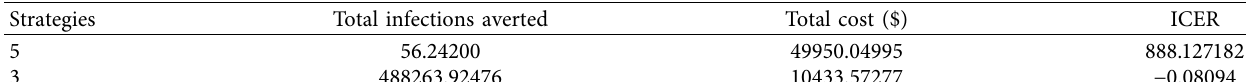
Table 6: Comparing cost and beneft of strategies 3 and